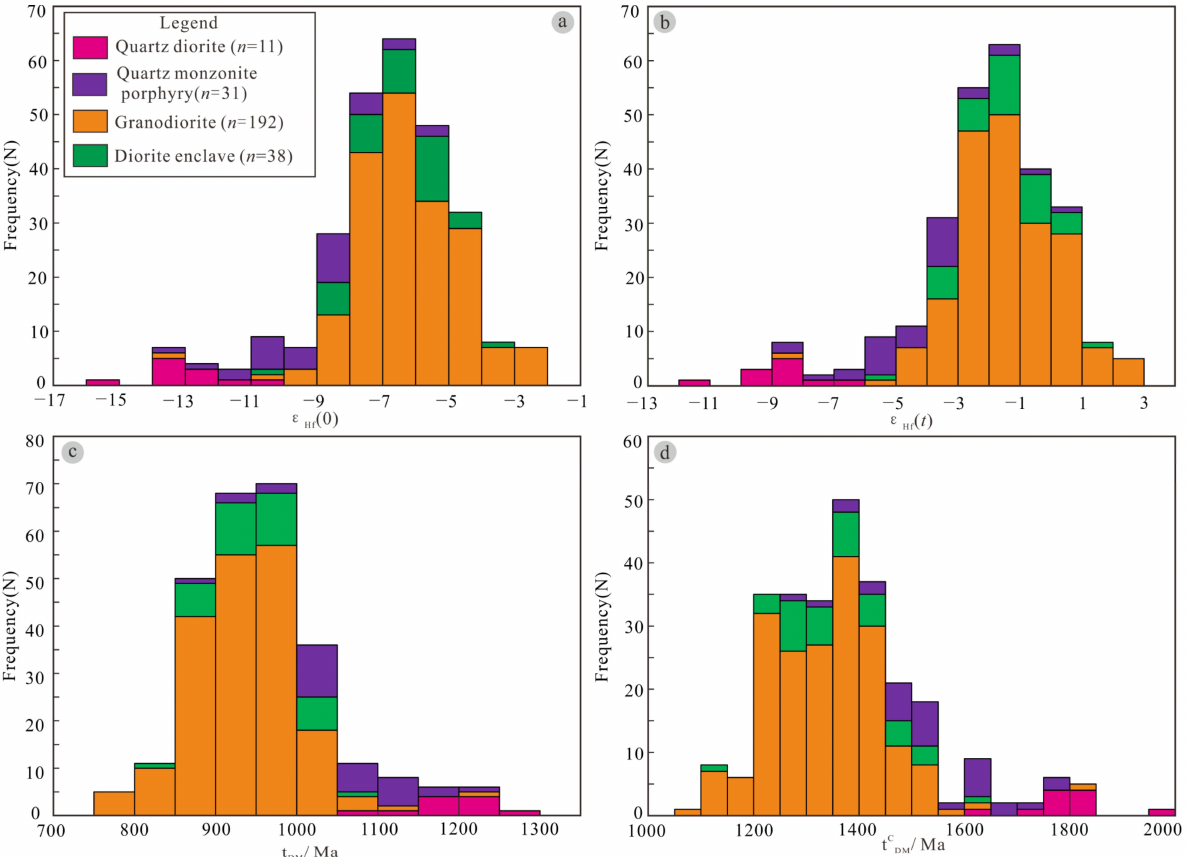
Figure 10. The histogram of ( a ) ε Hf (0), ( b ) ε Hf ( t ), ( c ) t DM , and ( d ) t C DM for zircons from Yangla granitoid